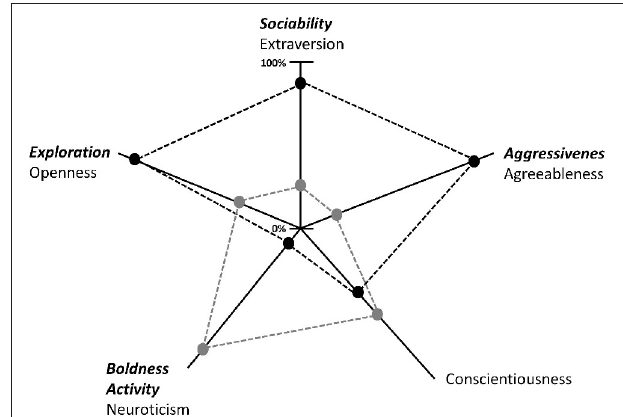
FIGURE 1 | The five personality factors in humans and how they describe the personality type of two imaginary individuals [adapted from (33)]. The equivalent personality factors described in animals are written in bold and italics. Scores are given from zero to 100 in percentages. For example, Individual A (black dashed lines and points) scored high in openness, extraversion and agreeableness, while Individual B (gray dashed lines and points) scored high on neuroticism and